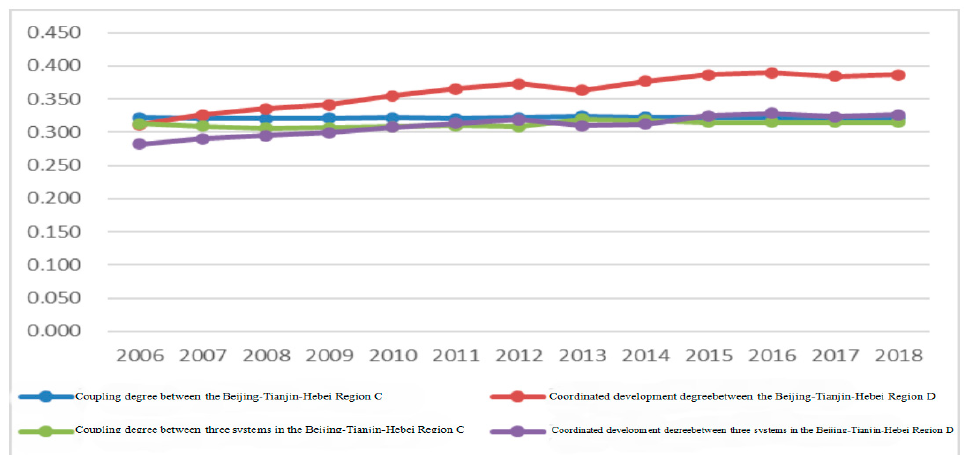
Figure 5. Coupling degree and coordinated development degree between the three regional systems and between the three subregions of the Beijing–Tianjin–Hebei region.